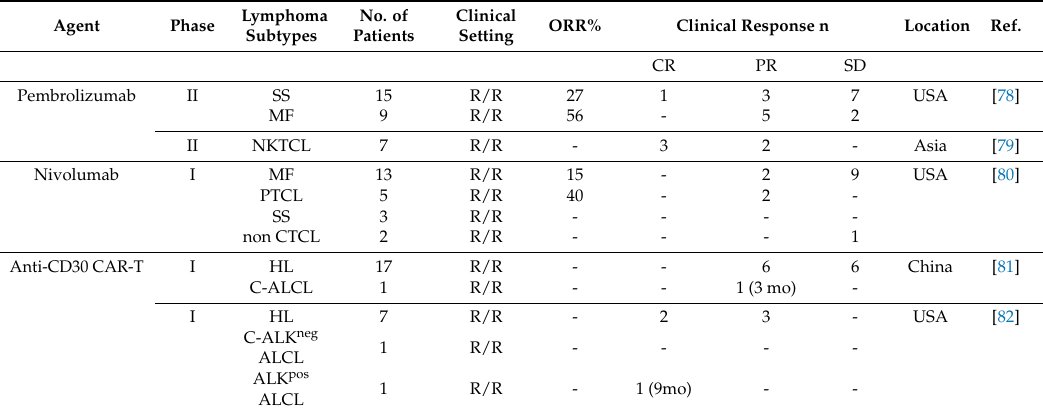
Table 2. Prospective trials of immune checkpoint agents and anti-CD30 chimeric antigen receptor (CAR)-T cell in T-NHL. Lymphoma No. of Clinical Agent Phase ORR% Clinical Response n Location Subtypes Patients Setting